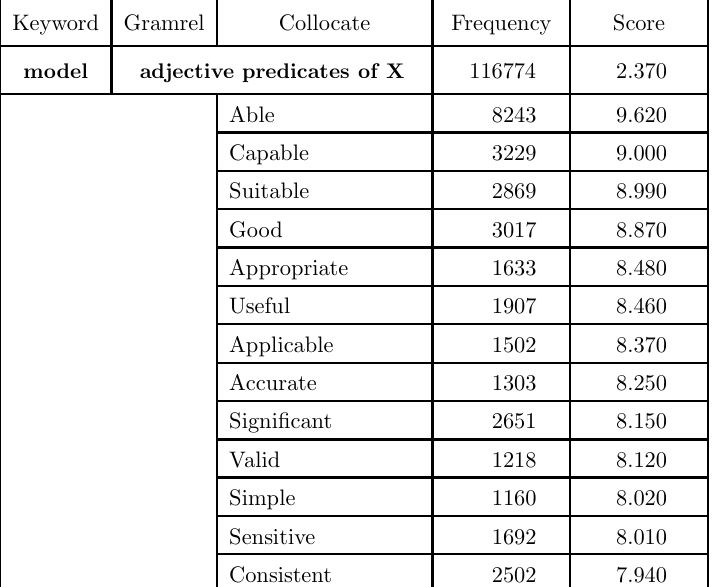
Table 1. Top 100 predicate adjectives of “model” (being an adjective predicate is the grammatical relation, or “Gramrel”, under study). The column “Frequency” lists absolute frequency of a given collocate, while “Score” provides a numerical score, computed in terms of logDice, which is an association score of expressions used in